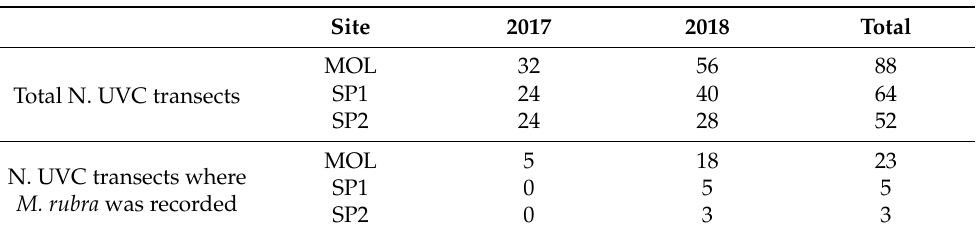
summers of 2017 and 2018 at the three study sites.